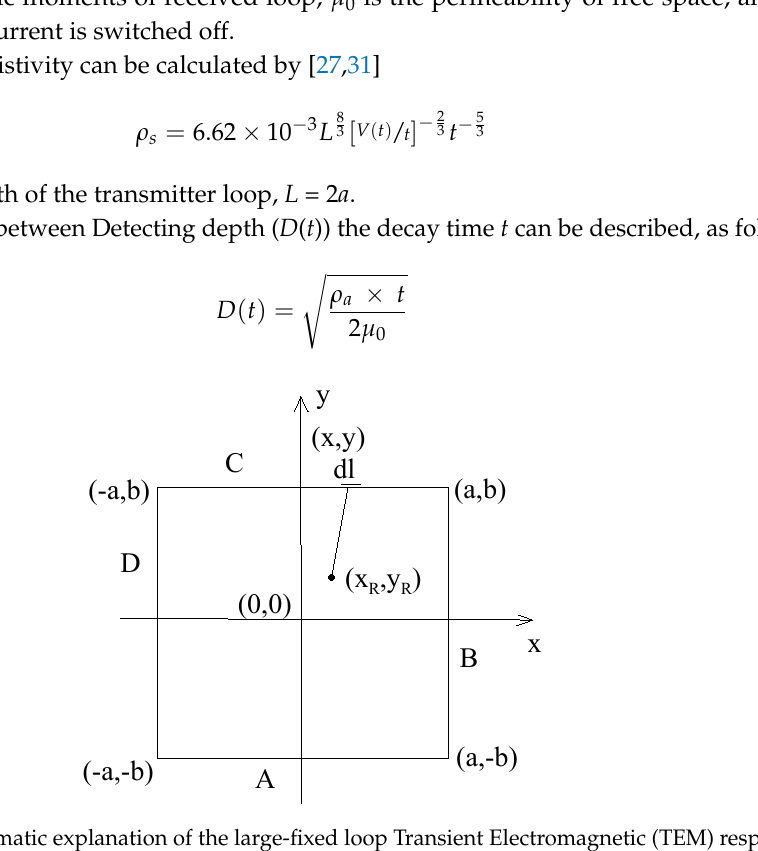
Figure 4. Diagrammatic explanation of the large-fixed loop Transient Electromagnetic (TEM) response.